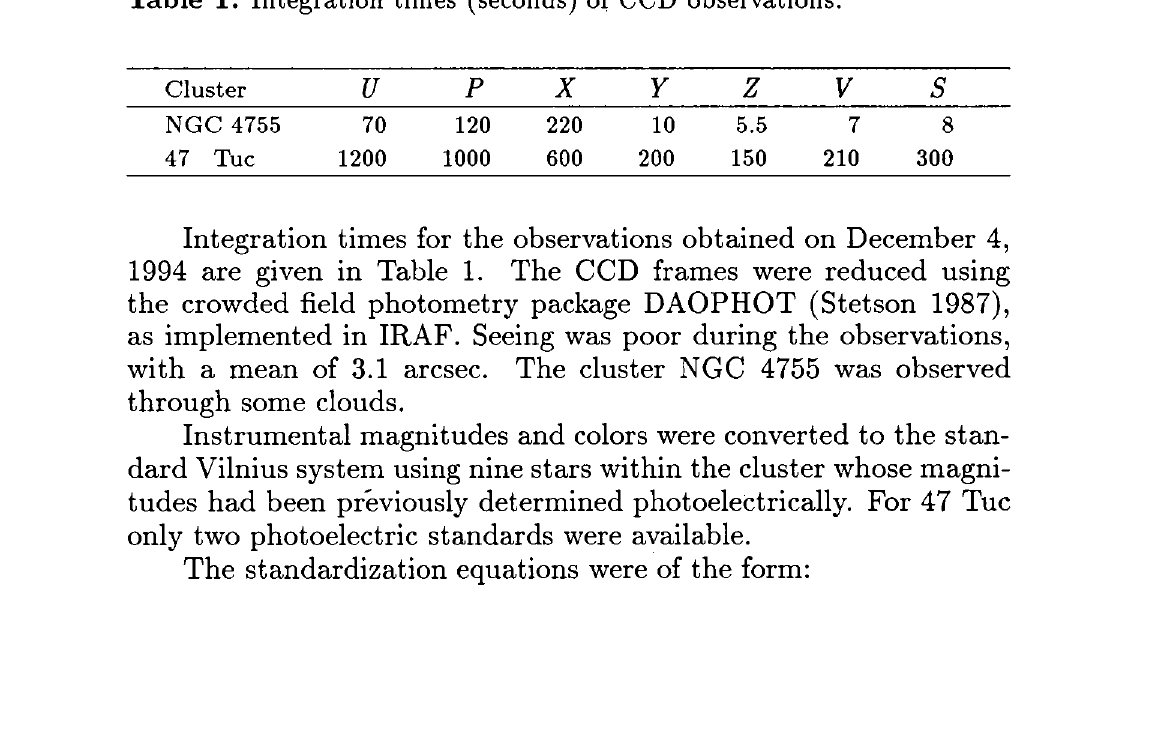
Table 1. Integration times (seconds) of CCD observations.